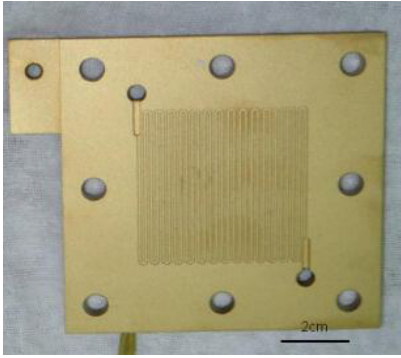
Figure 4. A coated titanium bipolar plate [56].